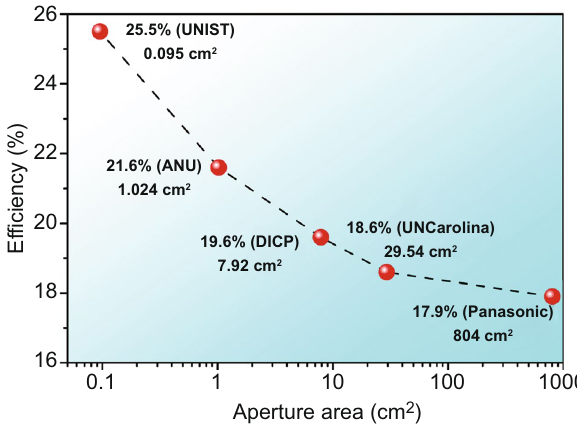
Fig. 8 The record efficiency of PSCs as a function of the aperture area in 2020. UNIST represents Ulsan National Institute of Science and Technology (Republic of Korea), ANU represents the Australian National University (Australia), DCIP represents Dalian Institute of Chemical Physics (China), UNCarolina represents the University of North Carolina at Chapel Hill